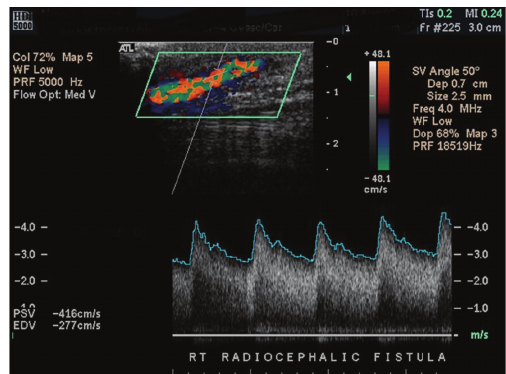
Figure 4: Normal arterio-venous fistula demonstrating marked spectral broadening and elevated velocities. The cephalic vein in this image is relatively superficial, sitting about a centimeter or less below the surface of the skin as denoted by the scale to the right of the color-flow image.